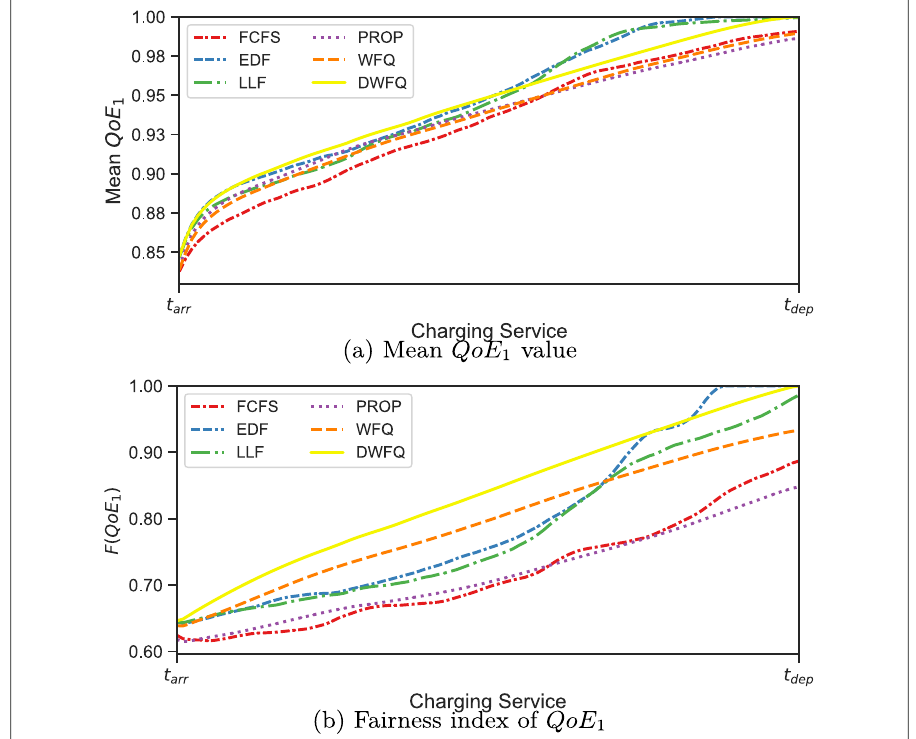
Fig. 9 Mean QoE 1 metric value and fairness index during the charging services using different queuing policies. All charging processes are normalized to the range [ t arr , t dep ]. 22 kW wall-boxes with 100% transformer